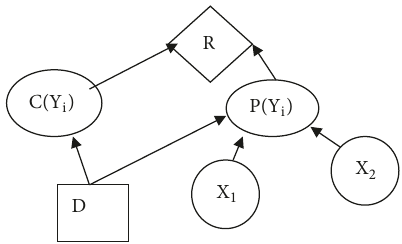
Figure 3: Influence diagram for the risk